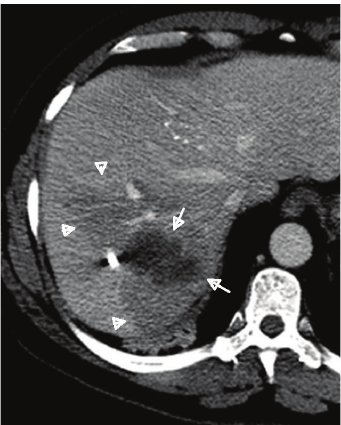
Figure 11: 56-year-old male patient with cholangiocarcinoma. Axial CT at delayed phase showing hypodense treated cholangiocarci- noma without residual enhancement (arrow), accompanied by halo of hyperdensity (arrow